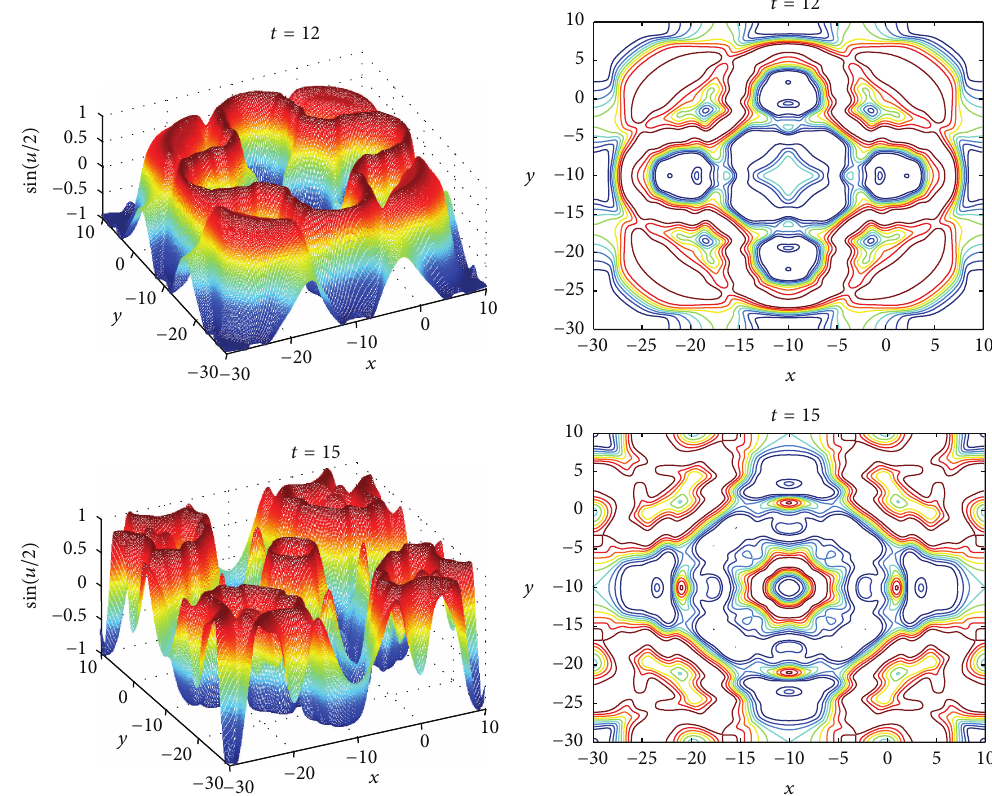
Figure 8: Collision of four circular ring solitons, at 𝑡 = 0, 2.5, 4,5, 6, 7.5, 8, 10, 12, 15 with 𝜌 = 0